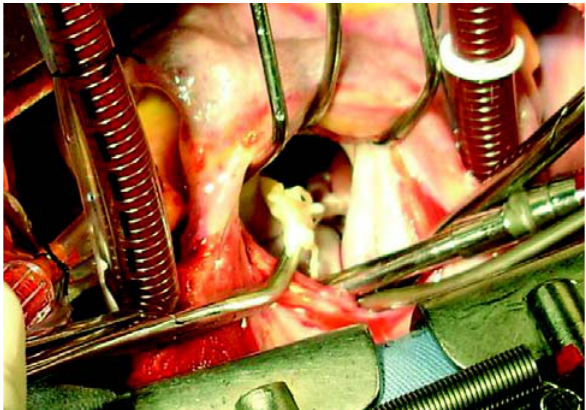
Fig. 2 - Ressecção da membrana do cor triatriatum, transformando o átrio esquerdo em uma câmara